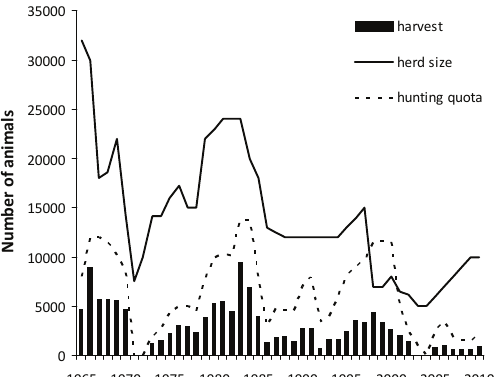
Figure 2. The estimated summer herd size, the hunting quota and harvest of wild reindeer in Hardangervidda, Norway, 1965 – 2011, based on various sources (Tveitnes, 1980; Krafft, 1981; Skogland, 1985b, 1989a, 1990b; Strand et al., 2004; Solberg et al., 2012). The summer herd size estimates are based on cited references that in some cases do not report if the herd is counted in sum- mer or winter, or if the estimate is based on the whole or segments of the herd. Also, estimates of the herd size reported in Skogland (1990b) and Strand et al. (2004) for the period 1970 – 1975 differ